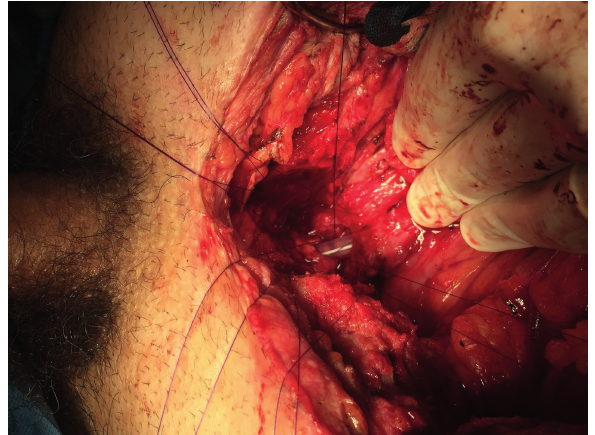
Figure 4 - Reanastomosis by abdominal